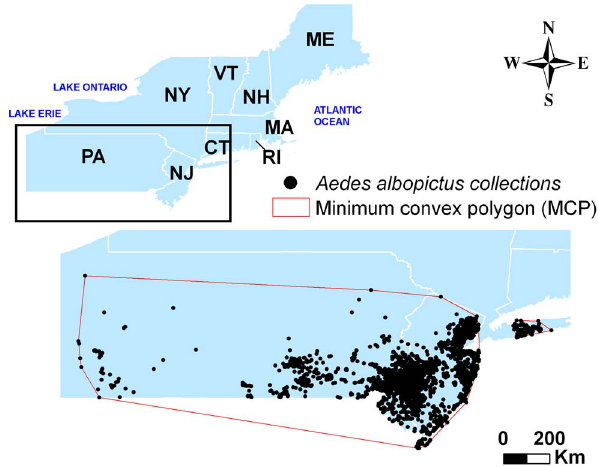
Figure 1. Study area and minimum convex polygon (MCP) around Ae.albopictus collection locations delineating general ‘‘presence’’ region for Maxent modeling.